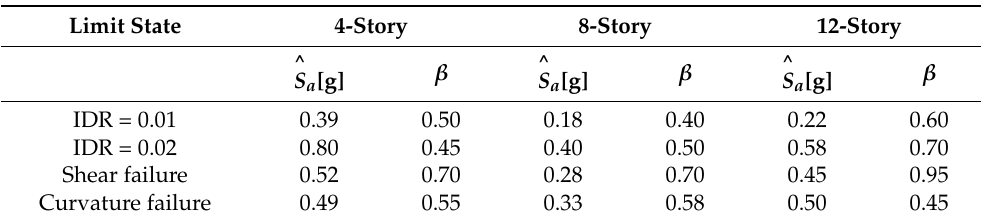
Table 4. Median intensity and dispersion for different failure limit states obtained via rigorous MSA and Mont Carlo simulations.